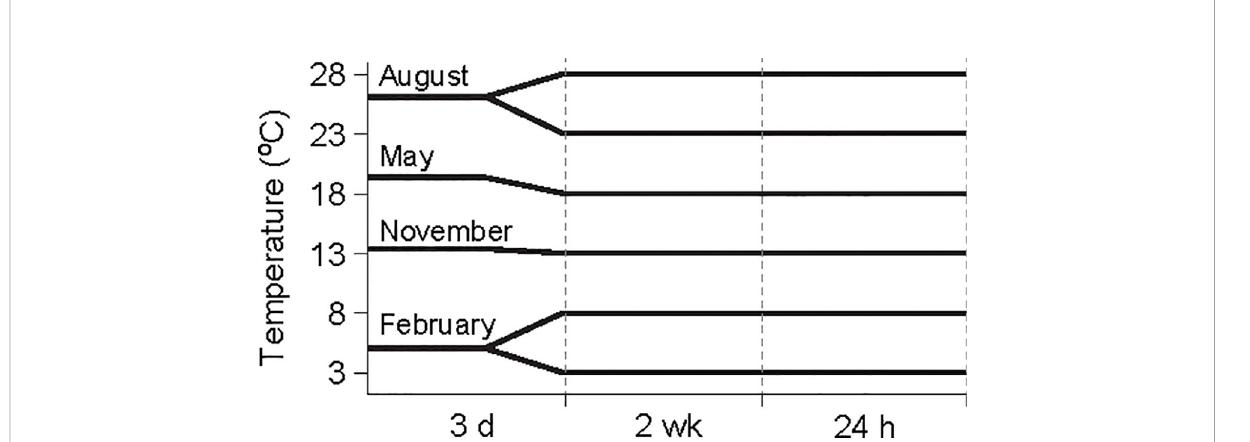
FIGURE 1 Experimental design and water temperature regimes in different seasons. Water temperatures were adjusted to 3°C and 8°C for February conditions to test the effect of winter warming on physiological activities in Anadara kagoshimensis , and 23°C and 28°C for August conditions to test the effect of summer warming. 13°C and 18°C represent November (autumn) and May (spring) conditions.